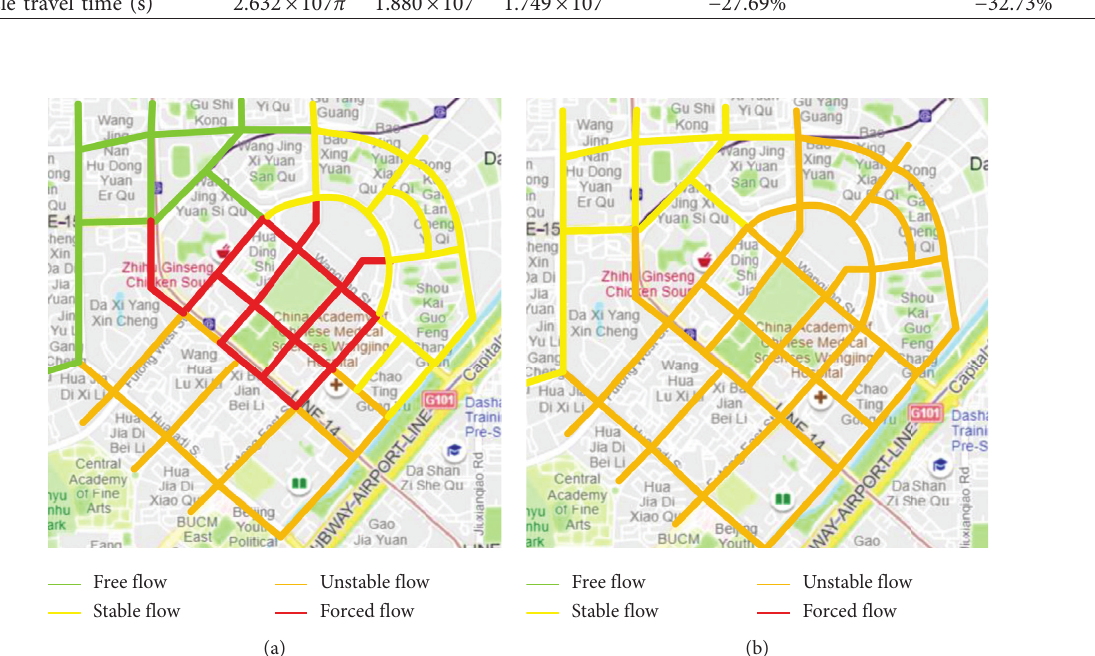
Figure 14: Comparison of traffic conditions before and after control: (a) before control; (b) after control.